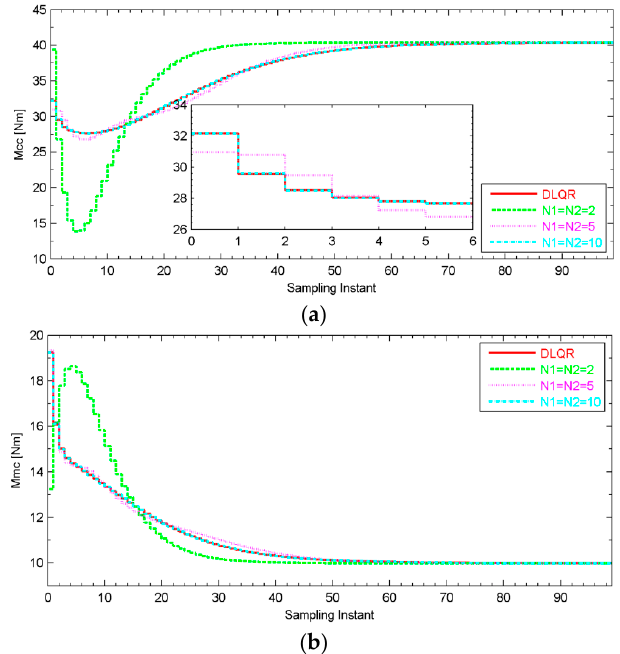
Figure 6. Difference between the optimum trajectories in the case of a 1 = a 2 = 0.8. The sampling interval is ten milliseconds. ( a ) Difference between the optimum trajectories of the clutch torque command M cc ; ( b ) Difference between the optimum trajectories of the motor output torque command M mc . Energies 2016 , 9 , 740